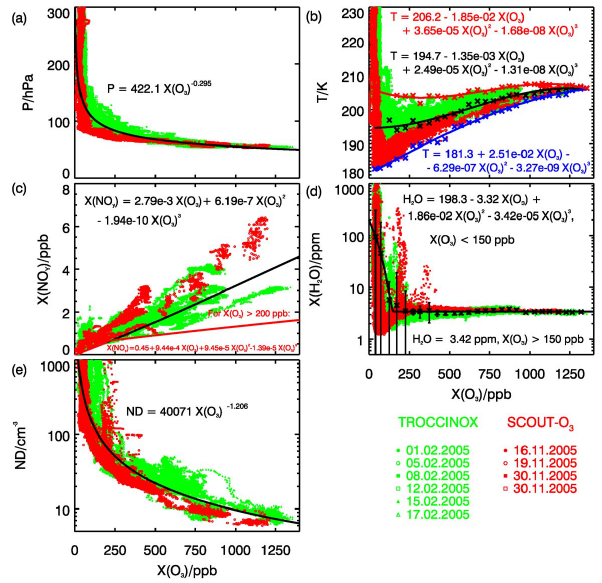
Fig. 2. Relationship of (a) pressure, (b) temperature, (c) x (NO y ) , (d) total water and (e) aerosol number densities with O 3 observed during TROCCINOX (green symbols) and SCOUT-O 3 (red sym- bols), used to initialise the CLaMS ST simulation to estimate typi- cal noontime Cl activation. Best fit relationships (lines) were deter- mined for the measured data except for x (NO y ) in panel (c) , where correlations from Michelson et al. (1998) are